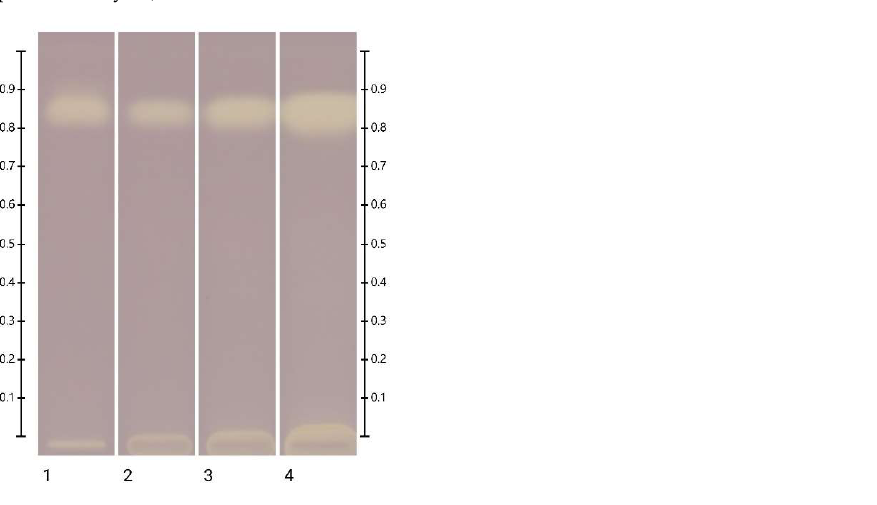
Figure 6. HPTLC images taken at 245 nm after development with toluene: ethyl acetate: formic acid (6:5:1, v/v/v ) ( a ); corresponding absorbance spectra ( b ); development with ethyl acetate ( c ); corresponding absorbance spectra ( d ); Track 1— ART short-term storage at 60 °C for 5 months (5 μL) (blue line in spectral analysis), Track 2—HMF (1 mg/mL) aqueous solution (2 μL) (green line in spectral analysis).